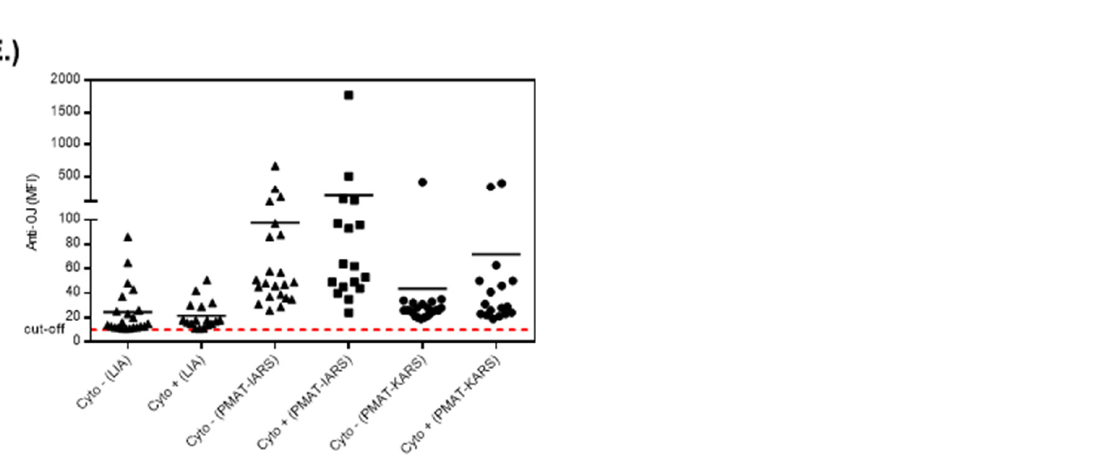
Figure 5. Lack of association of anti-OJ antibodies with distinct indirect immunofluorescence (IIF) patterns . Legend: Level of anti-OJ antibodies in relation to the IIF staining patterns (AC-19, cytoplasmic dense fine speckled; AC-20, cytoplasmic fine speckled; AC-21 anti-mitochondria-like; AC-22: Golgi complex) on HEp-2 cells for the results derived from particle based multi-analyte technology (PMAT) and line immunoassay (LIA). ( A ) Anti-OJ antibodies defined by LIA, ( B ), by PMAT (combination of IARS and KARS), ( C ) anti-IARS by PMAT, ( D ) anti-KARS by PMAT and ( E ) all assays separated by presence or absence of cytoplasmic staining.